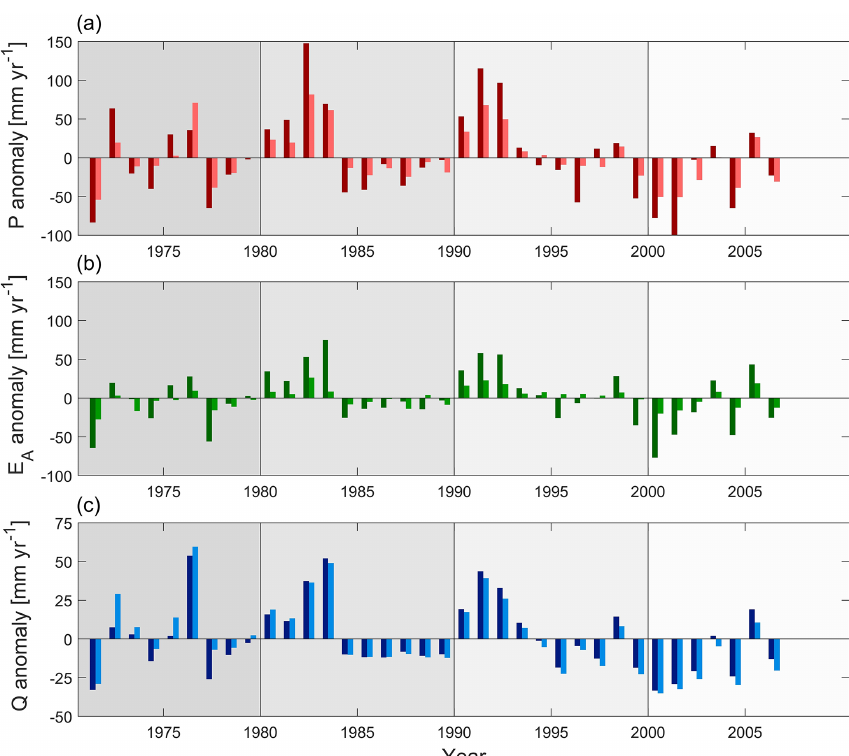
Figure 10. (a) Precipitation anomalies, (b) actual evaporation anomalies (here: E A = E I + E T ), and (c) streamflow anomalies over the study period. All anomalies are calculated based on the 1970–2006 mean values. The dark shaded bars indicate the combined flows to and from the upper basin (ID1–ID6); the light shaded bars show the flows to and from the lower basin